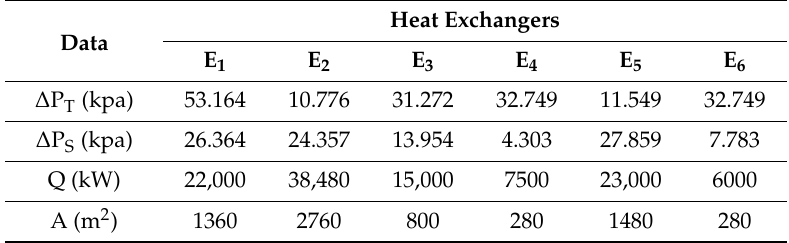
Table A3. Exchanger’s pressure drop, heat duty, and exchangers’ area for existing